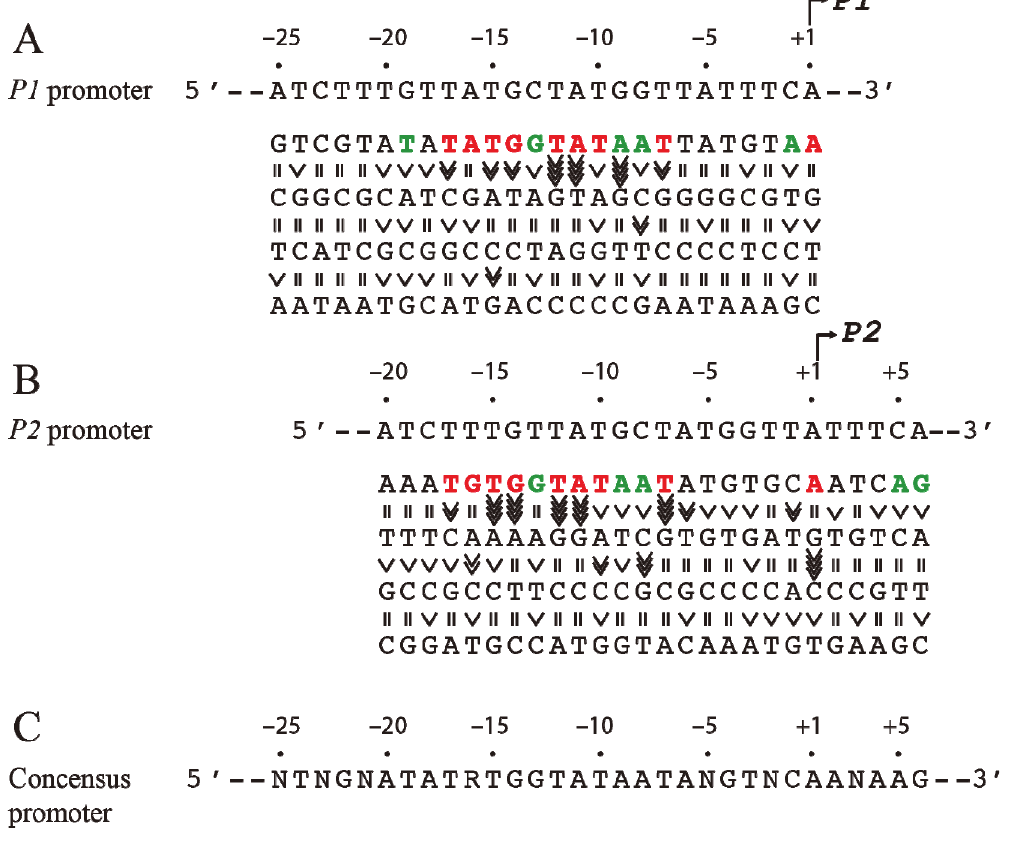
Figure 2. Base pair requirement in gal promoters. ( A ) The DNA sequence from (cid:2)25 to +1 of P1 and a summary of the effect of base pair changes from +1 to (cid:2)25 on P1 transcription; ( B ) The DNA sequence from (cid:2)20 to +6 of P2 and a summary of the effect of base pair changes from (cid:2)20 to +6 on P2 transcription; ( C ) Consensus promoter region of P1 and P2 derived from the results shown in (A) and (B). R = A or G, N = any nucleotide. Base pair is in red if it is unique for promoter function, green if it improves promoter function, and black if it is degenerate. The symbol “>>>>” in vertical shapes represents 4.1-fold or more difference in promoter function from the wild type; “>>>”, 3.1 to 4-fold; “>>”, 2 to 3-fold; “>” less than 2-fold; “=” indicates equal (reproduced with permission from Elsevier,